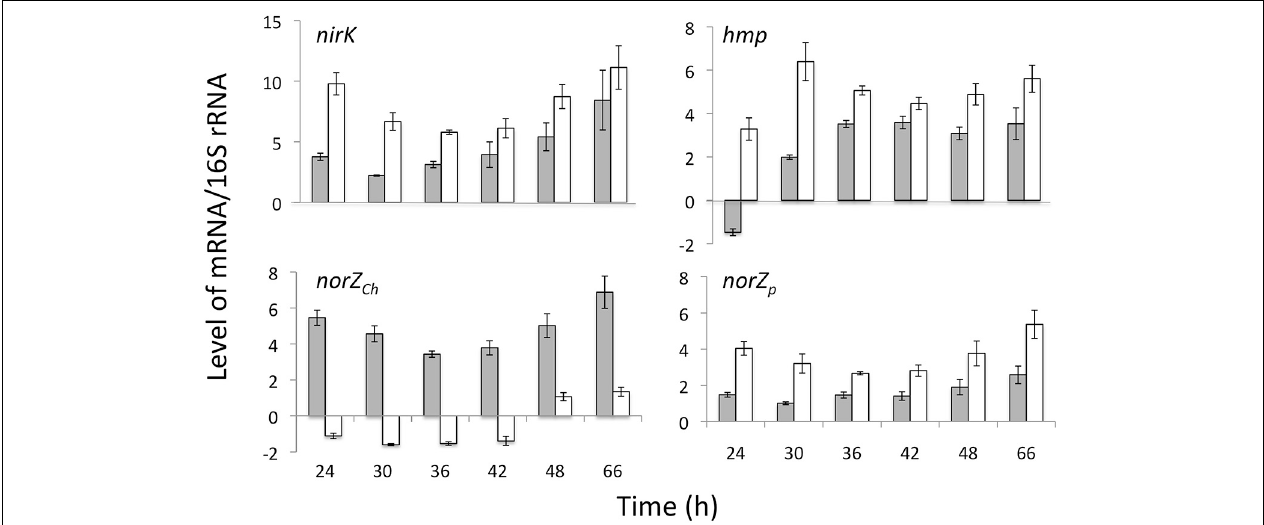
FIGURE 2 | Levels of mRNA of select genes in S. wittichii RW1 WT (gray bars) and norZ ch mutant (white bars) in batch cultures over time. Error bars represent standard error for 5 replicate experiments performed with separate cultures on different days.